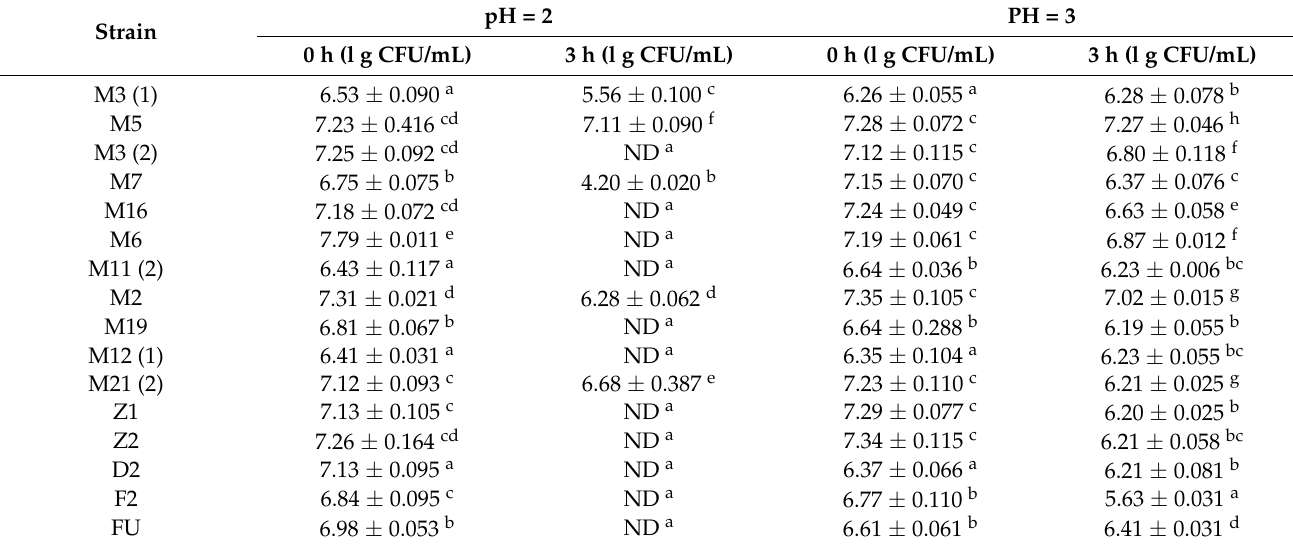
Table 5. 16 strains of LAB acid resistance results.